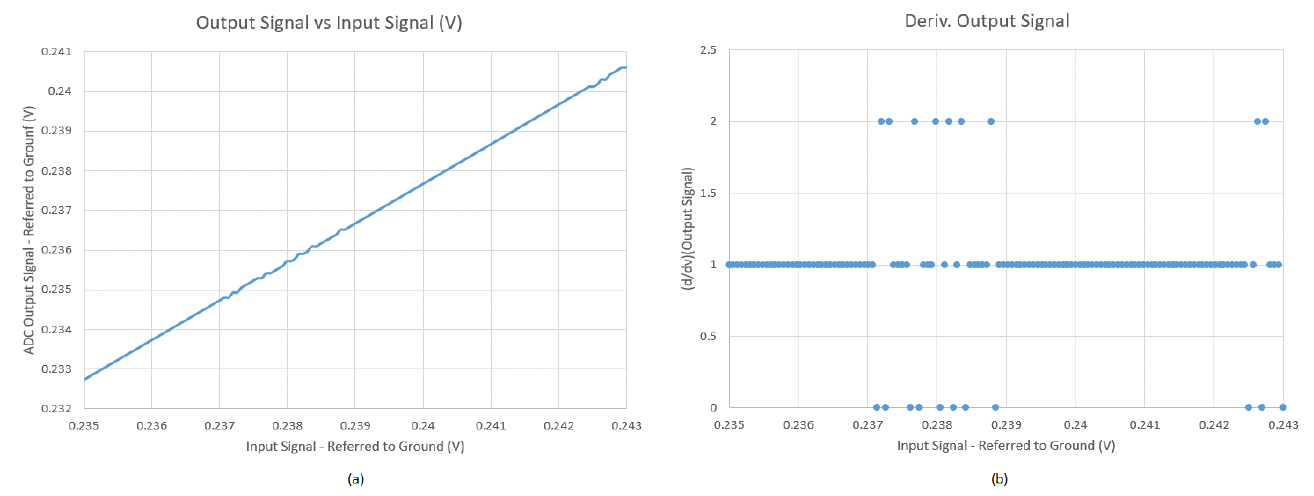
Figure 11. Short signal range demonstration. ( a )—The absolute output signal (namely the equivalent analogue version of the digital output), as a function of the input voltage level; ( b )—The absolute ADC differential non-linearity (DNL), as a function of the input voltage level.